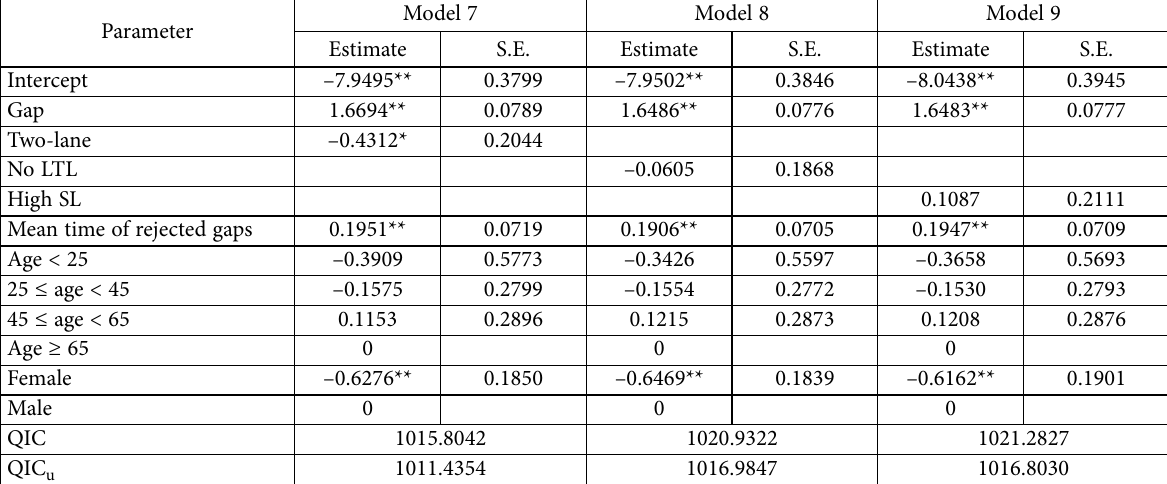
Table 7. Parameter estimates of the models on the mean time interval of rejected